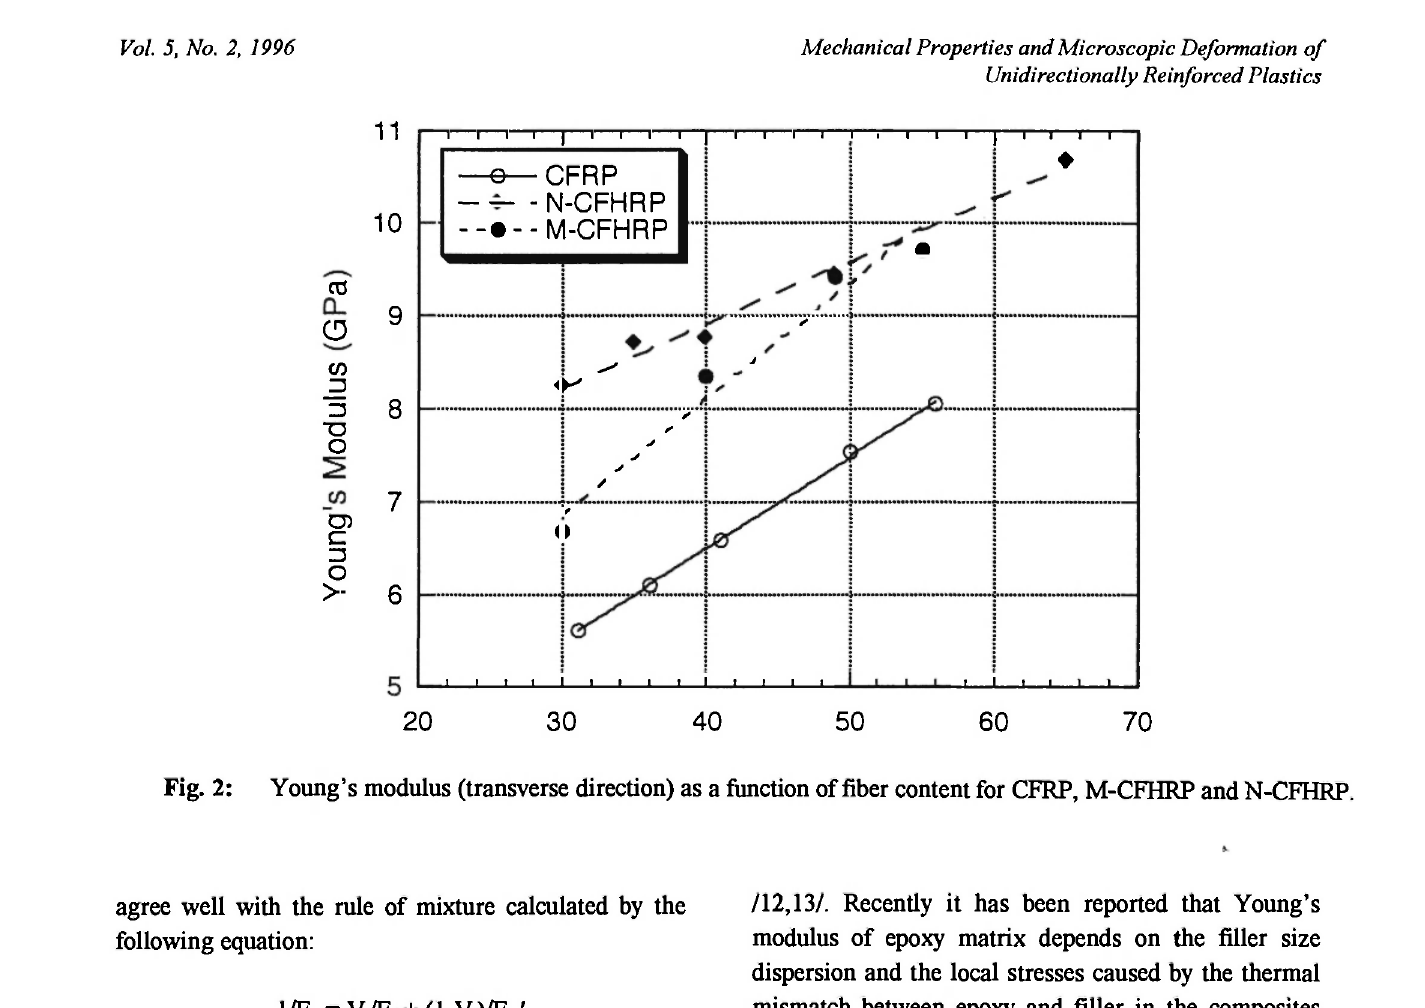
Fig. 2: Young's modulus (transverse direction) as a function of fiber content for CFRP, M-CFHRP and